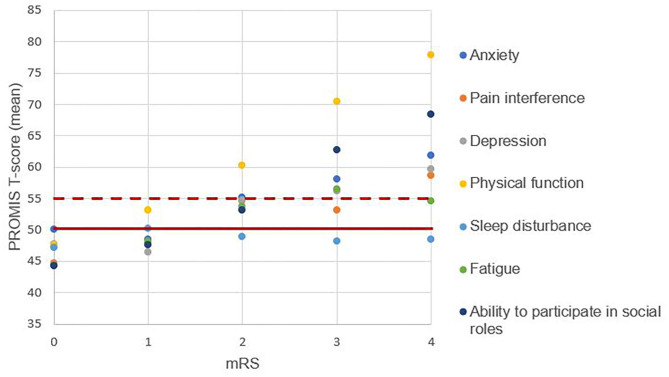
Patient-reported outcomes across the levels of disability. One dot represents the mean T-score. The solid horizontal line represents the mean of the general population, the dotted horizontal line represents the score that is meaningfully worse than the general population. A higher T-score represents worse patient-reported health.